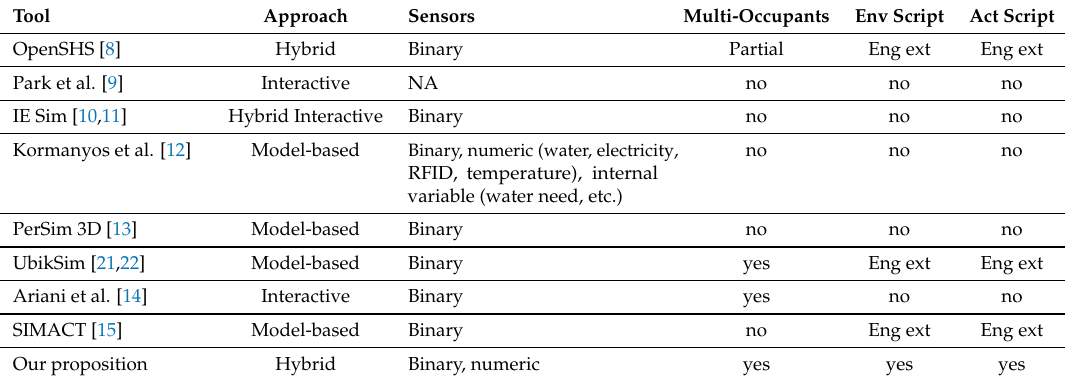
Table 1. Sumary of propositions according to our criteria. Act script: actuator scripting; Env script: environment scripting; Eng ext: engine extension; NA: not